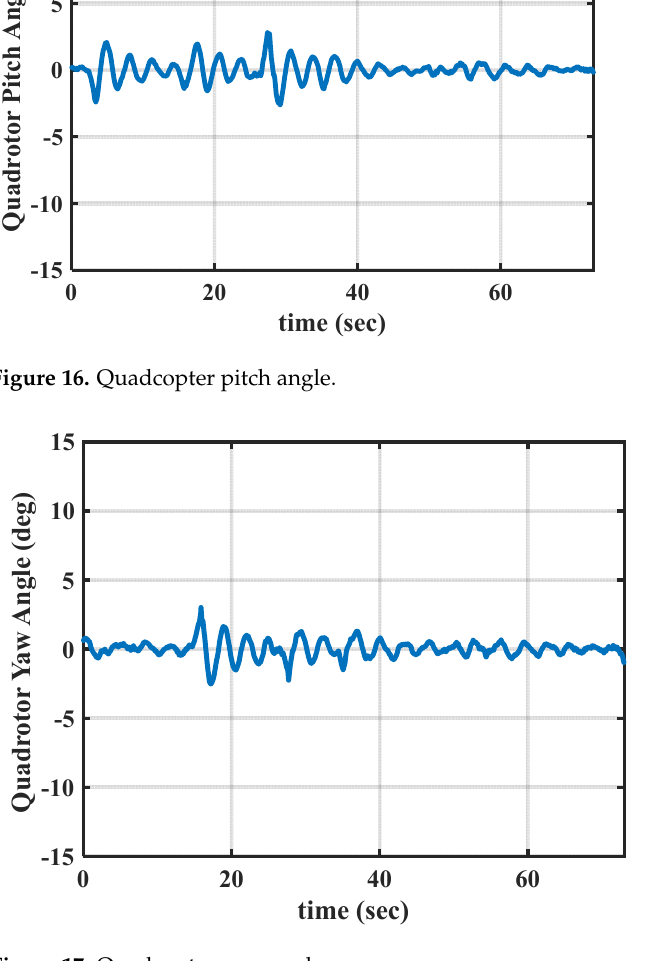
Figure 17. Quadcopter yaw angle.